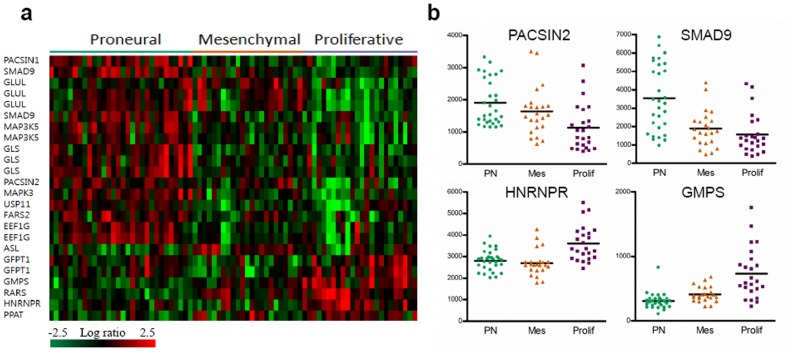
Molecular signatures of CARS and FARS interaction networks in patients with GBM.(a) We identified probe sets whose expression most strongly correlated with CARS and FARS in each subtype. This analysis identified that 88 resulting probe sets of the 48 genes. Then, we performed a supervised clustering with the probesets and GBM subtypes such as proneural (PN), proliferative (Prolif) and mesenchymal (Mes). This analysis showed that 24 probeset as signature genes were differentially expressed in the three discrete subgroups (P = 0.001). The 24 probe sets are presented in matrix format, where rows represent individual genes and columns represent each tissue. Each cell in the matrix represents the expression level of a gene in an individual tissue. Red and green cells reflect high and low expression levels, respectively. (b) Tumor subgroups are distinguished by interactors of CARS and FARS. Horizontal bars denote mean values.